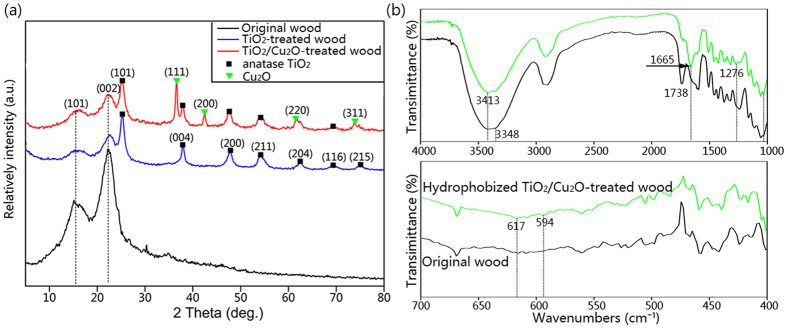
(a) XRD patterns of the original wood, the TiO2-treated wood, and the TiO2/Cu2O-treated wood. (b) FTIR spectra of the original wood and the hydrophobized TiO2/Cu2O-treated wood.